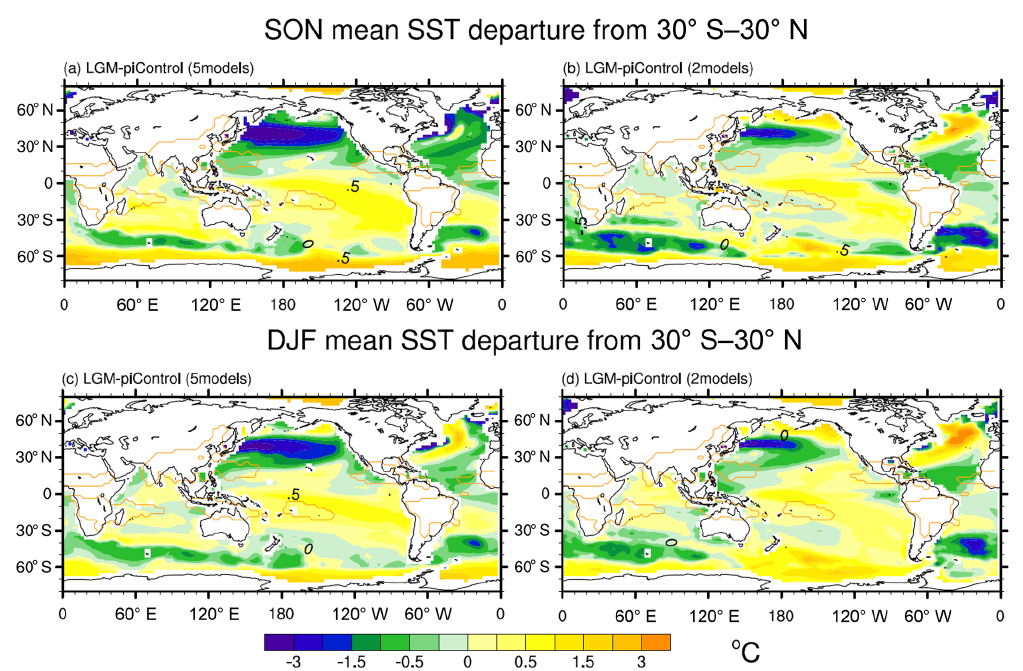
Figure 15. SON mean (a, b) and DJF mean (c, d) SST differences between LGME and piControl derived from (a, c) the five models and (b, d) the two models. Only those areas where the signal-to-noise ratio exceeds 1 are plotted. The area average of tropical (30 ◦ S–30 ◦ N) SST change is distracted subtracted to make it clearer to illustrate the regional differences.